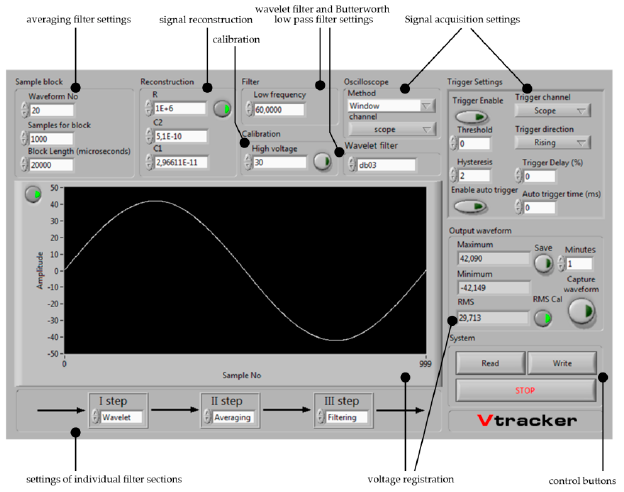
Figure 9. Graphical user interface in the program for configuration, control, and visualization of the high voltage measurement process.